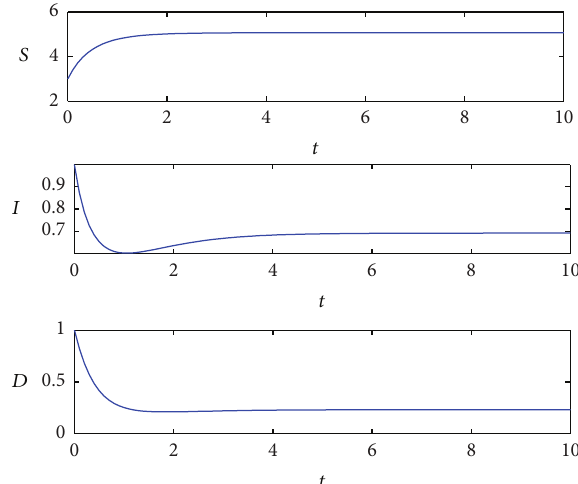
= 1 , and 𝑢 = 2 , then 𝑅 = 2 > 1 , 1 2 0